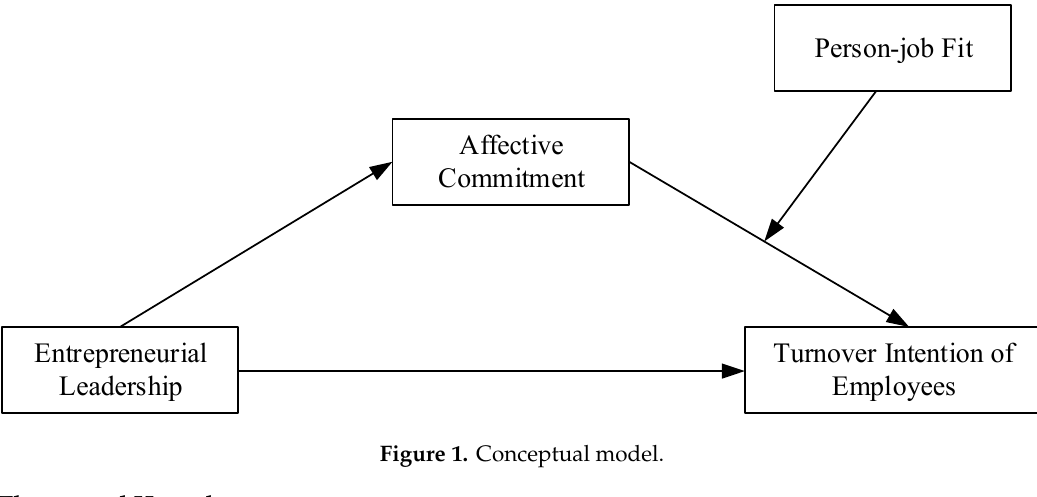
Figure 1. Conceptual model.